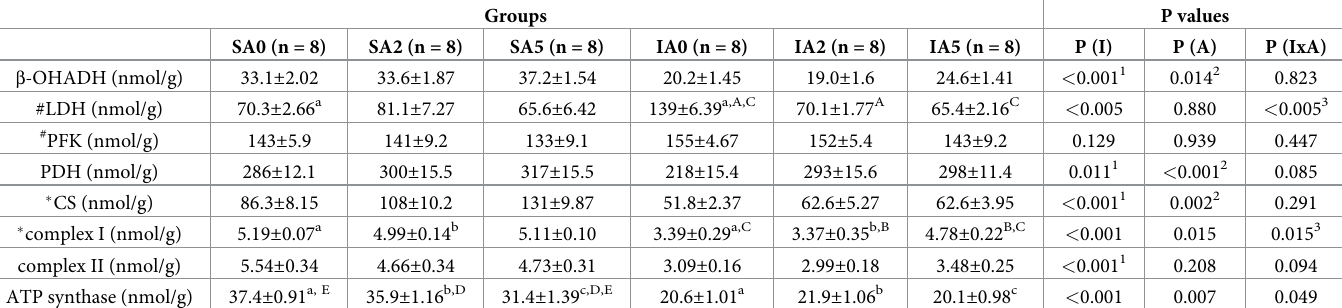
Table 3. Energy metabolism markers.